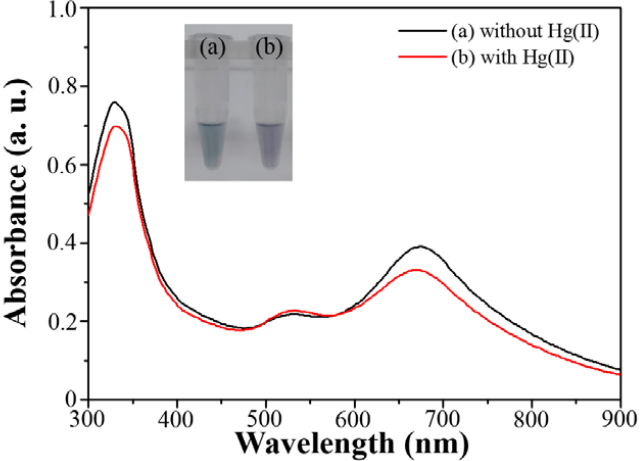
Figure 3. UV-Vis spectra of the H-AuNS probe ( a ) without and ( b ) with Hg(II) (1.0 µM) in the absence of HCl/Au(III)/H 2 O 2 solutions. Inset: photographs of the prepared AuNPs solutions.